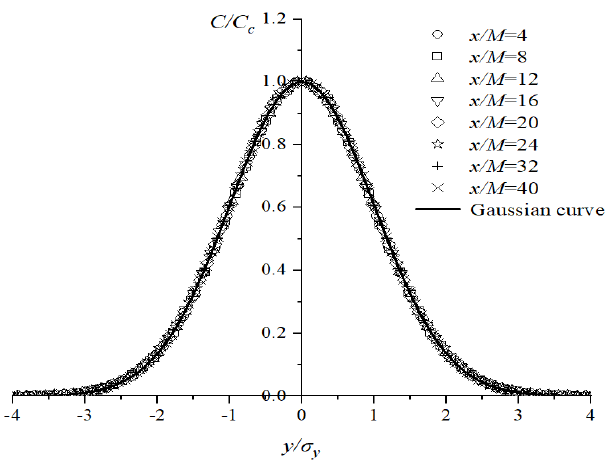
Figure 8. Lateral profiles of the normalized time-averaged concentration C / C c at different down- stream locations for S2.